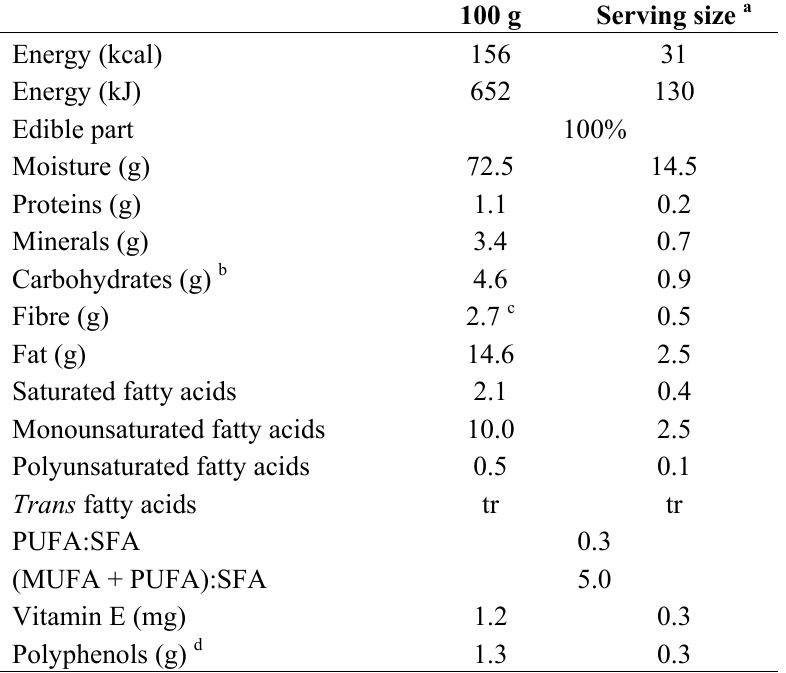
Table 4. Nutritional characteristics of “ alcaparras ” stoned table